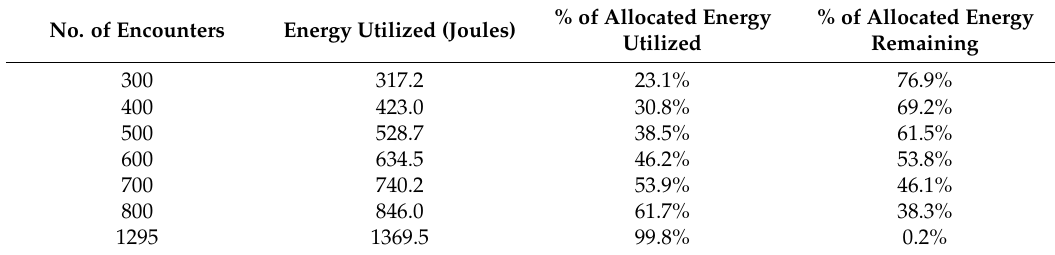
Table 2. The percentage of energy allocated to the OppNet that is utilized in exchanging contact information alone for a different number of encounters within 24 h (battery energy = 45,738 Joules; and allocated energy = 1372.14